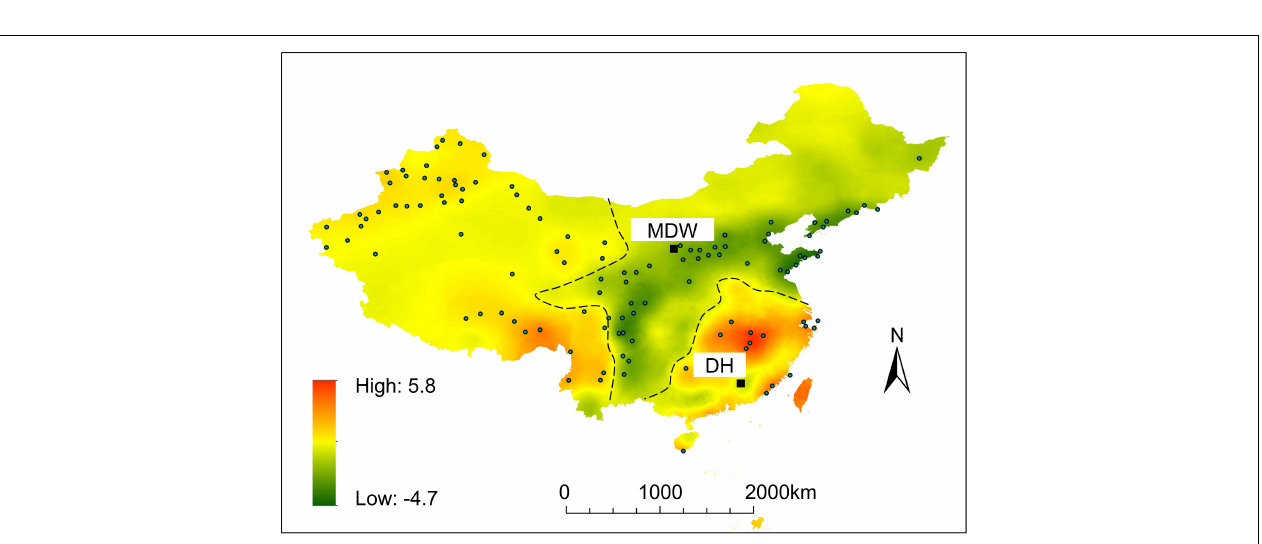
FIGURE 8 | Gridded trends of annual precipitation in China. Annual precipitation data of 591 meteorological observatories from 1960 to 2005 were obtained from the China Meteorological Data Service Center (CMDC). A linear trend of precipitation was calculated at each site, and only the 110 sites with a significant level of p < 0.05 were reserved. The Kriging interpolation method was applied to obtain the gridded precipitation trends.